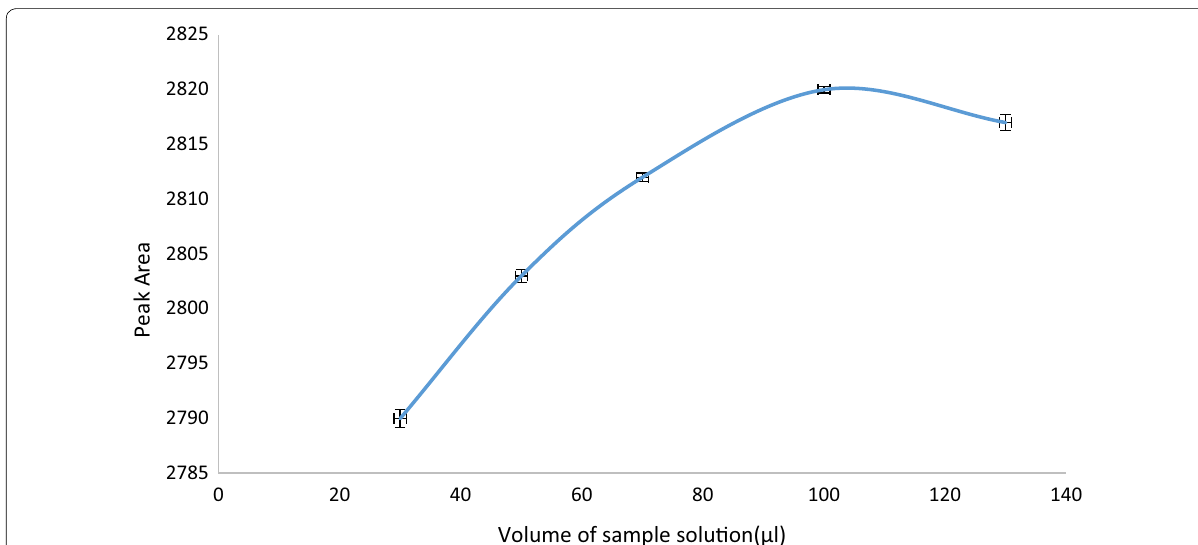
Fig. 8 Effect of volume of sample solution on extraction efficiency of CBZ (Experimental conditions: pH: 7.5; amount of adsorbent: 5 mg; volume of eluent: 30 µL and number of draw/eject cycle for sample solution and eluent: 10